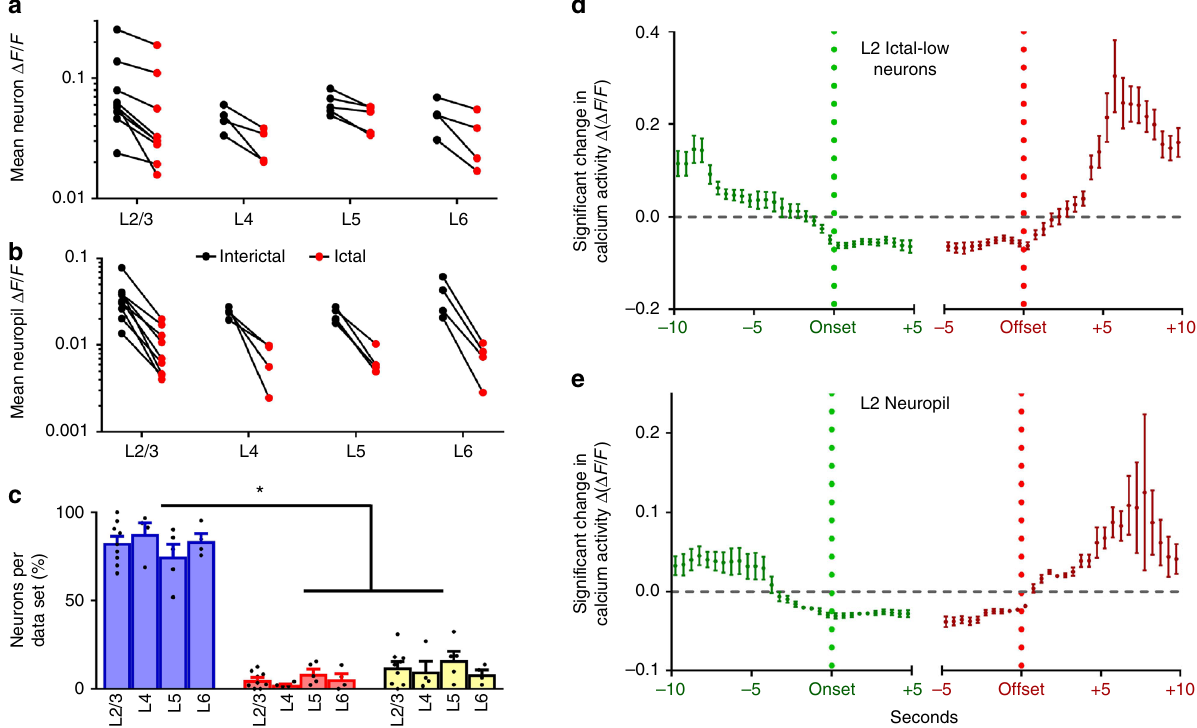
Fig. 2 Activity changes in the ictal state. a Average calcium activity ( Δ F / F ) was signi fi cantly reduced in the ictal state compared to the interictal state for neurons across all layers. Line segments connect interictal (black disk) and ictal (red disk) mean activity within a fi eld of view. Each comparison was statistically signi fi cant based on the Wilcoxon matched-pairs signed rank test ( p < 0.01). b Similar fi ndings in neuropil ( p < 0.001 for all comparisons). c Signi fi cantly greater percentage of ictal-low compared to ictal-high or neutral neurons was seen across layers ( p < 0.0001 across data sets; 2-way ANOVA with Tukey ’ s multiple comparisons. d Temporal pro fi le of signi fi cant change in ictal-low neuron activity compared to baseline, where Δ ( Δ F / F ) represents deviation from the average Δ F / F . Note that mean Δ ( Δ F / F ) (±s.e.m.) starts falling about 7 s before seizure onset, returning to baseline following seizure offset (n/bin = 9 – 155 neurons). e Temporal pro fi le of change in neuropil activity shows that neuropil activity starts falling gradually more than 5 s prior to seizure onset, with a similar return to baseline after seizure offset (n/bin = 2 – 53 neuropil